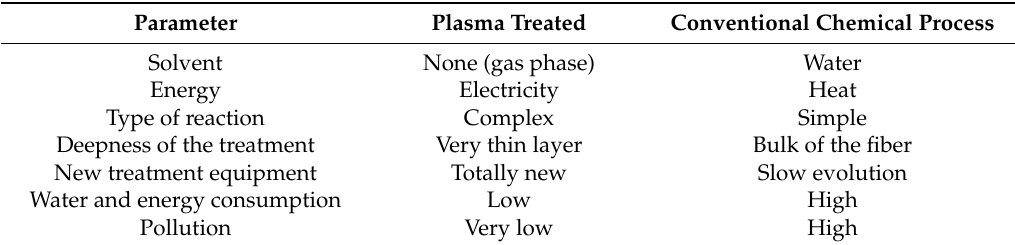
Table 1. Comparison of plasma treated and conventional chemical process (adapted from Ref. [5], with